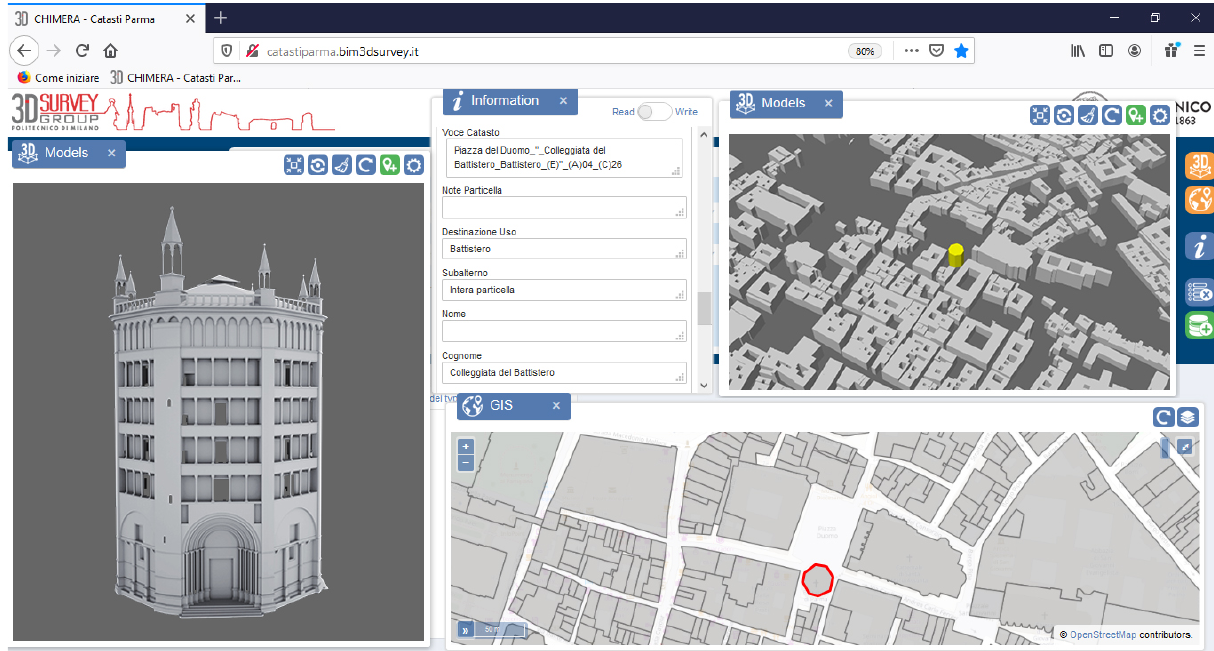
Figure 5. Image shows data referred to the Baptistery: 2D map, 3D at LOD 1, 3D at LOD 4 and data related to the selected